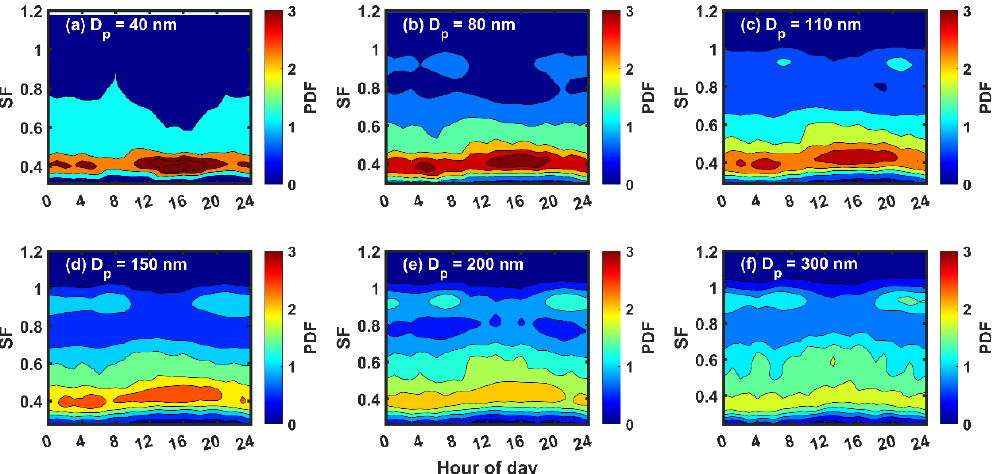
Figure 5. Diurnal variations in size-resolved shrink factor (SF) probability distribution functions (PDFs) for particles with diameters of (a) 40, (b) 80, (c) 110, (d) 150, (e) 200, and (f)